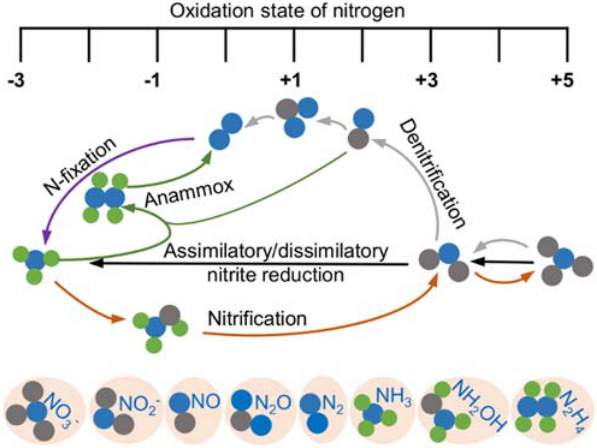
Figure 1. Redox cycle for nitrogen driven by prokaryotes. Shown are the major biological nitrogen transformation pathways, each of which are represented by lines in the same color, and the relative oxidation state at which they occur.